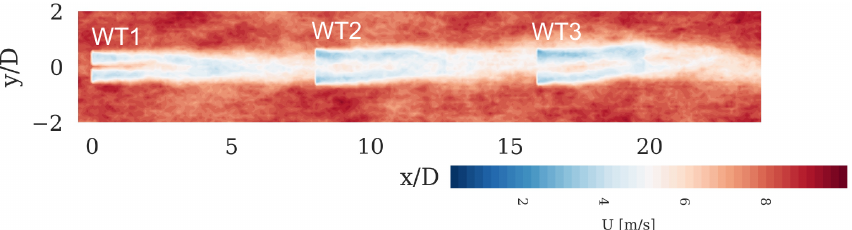
Figure 1. Instantaneous two-dimensional flow visualization of a three-turbine (WT1–WT3) FAST.Farm simulation in turbulent inflow, sampled at hub height and colored by velocity